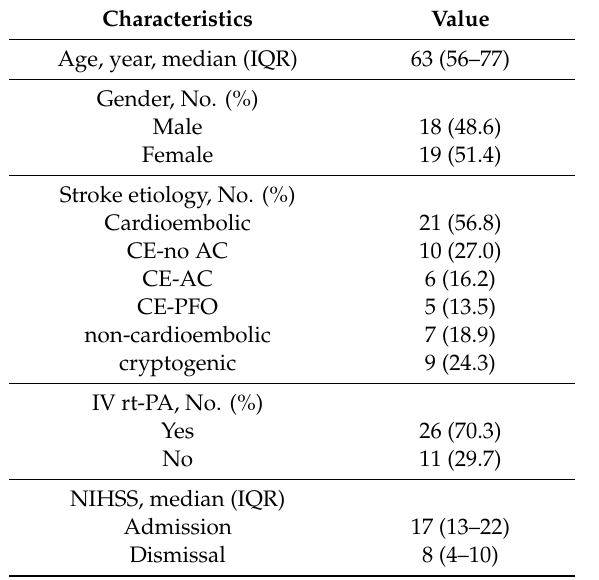
Table 1. Clinical characteristics of patients and collected thrombemboli for histological